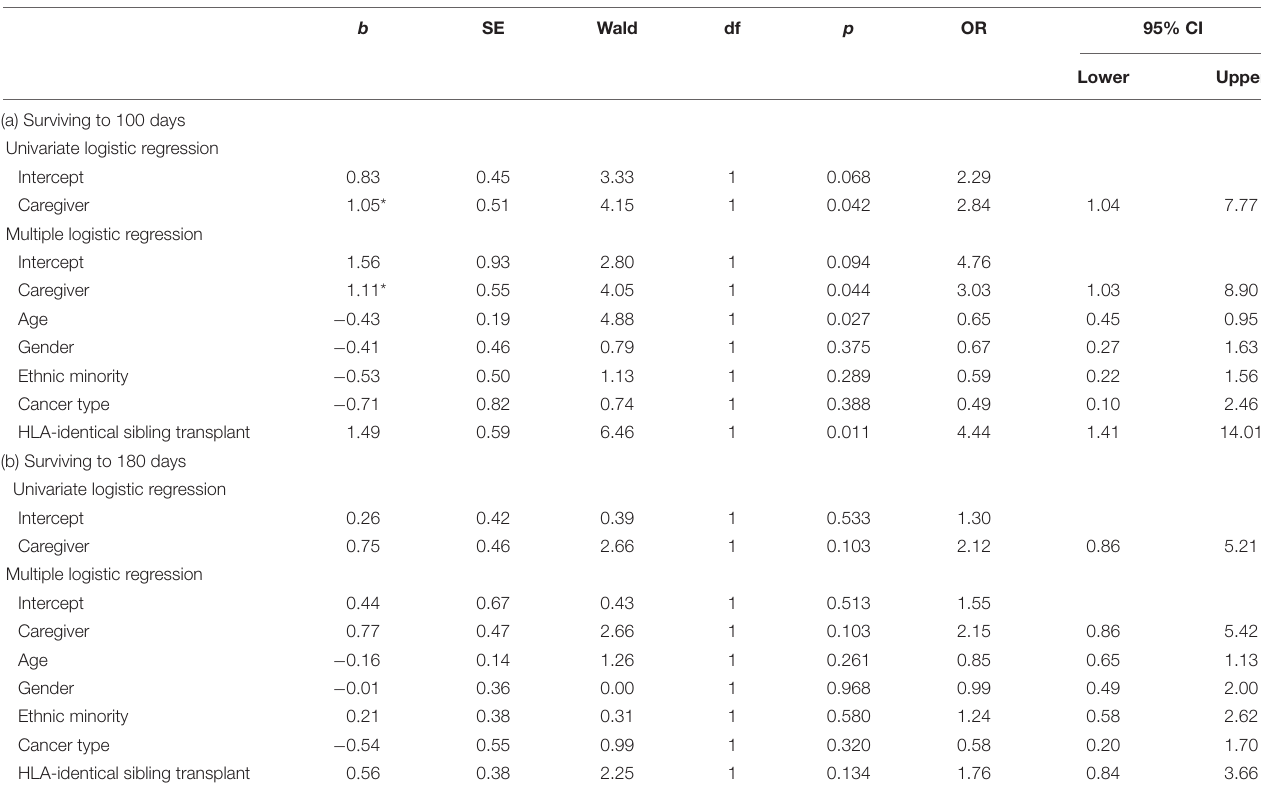
TABLE 2 | Availability of caregiver and surviving to 100 and 180 days after transplant, logistic regression without and with adjusting for covariates ( N = 173). b